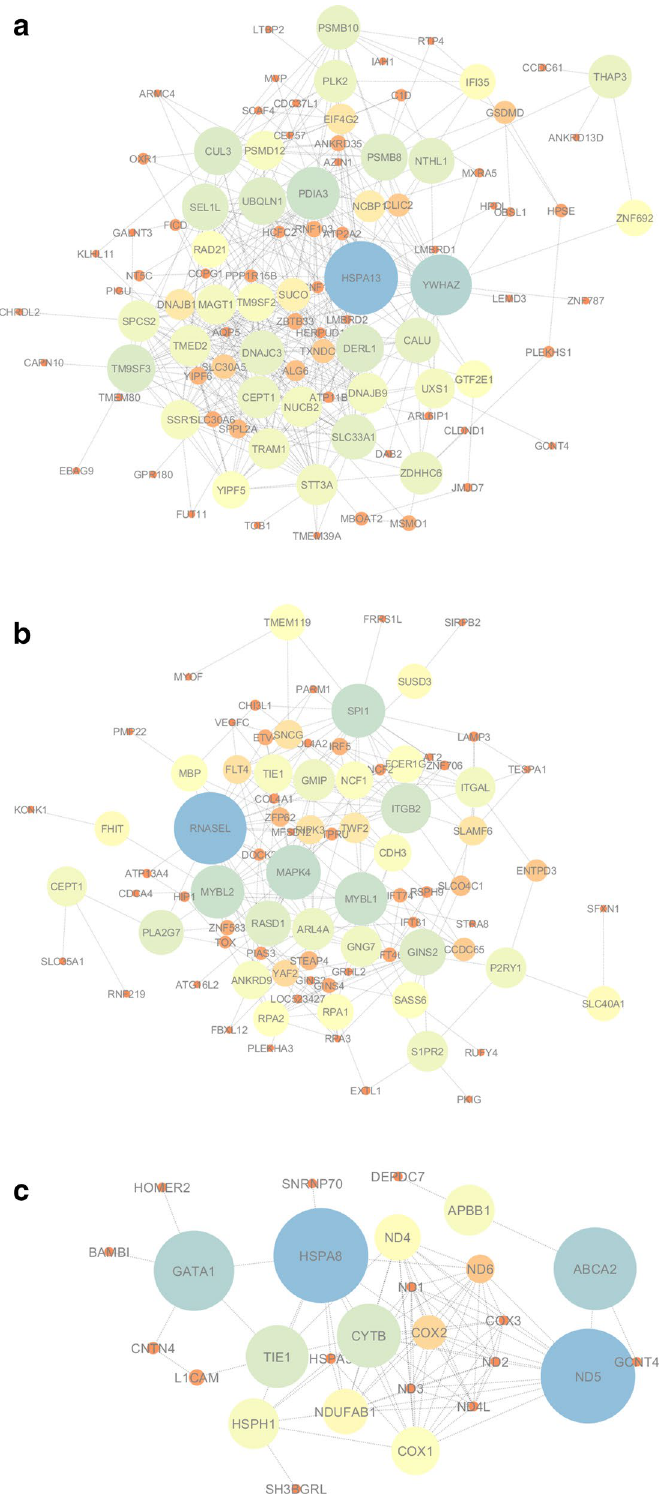
Figure 5. Gene networks for DEGs involved in the lactation process. ( A ) BP vs. P; ( B ) BP vs. AP; and ( C ) P vs. AP comparisons are shown. The mapping strategy of using low parameter values corresponding to bright colors was used for node coloring. The brightest color is green and the darkest color is red. The default middle color is